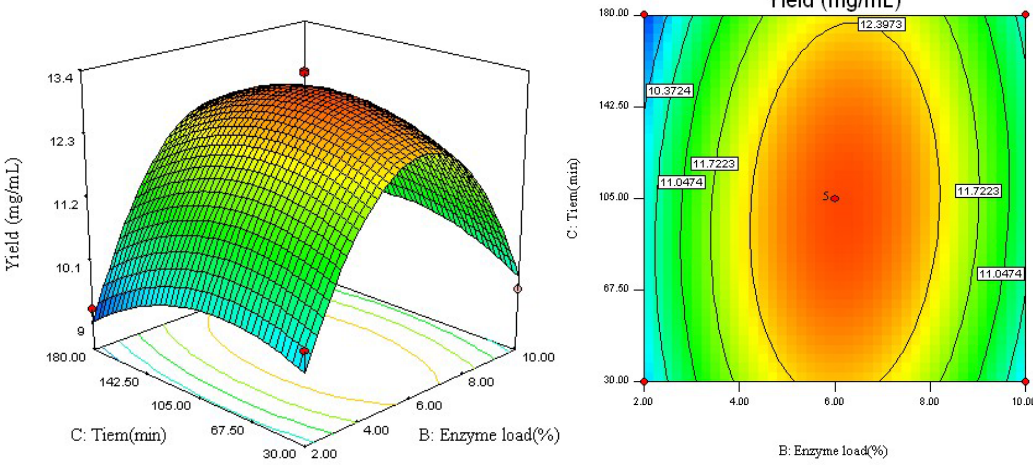
Figure 4. Response surface plot and contour plot of enzyme load and reaction time.